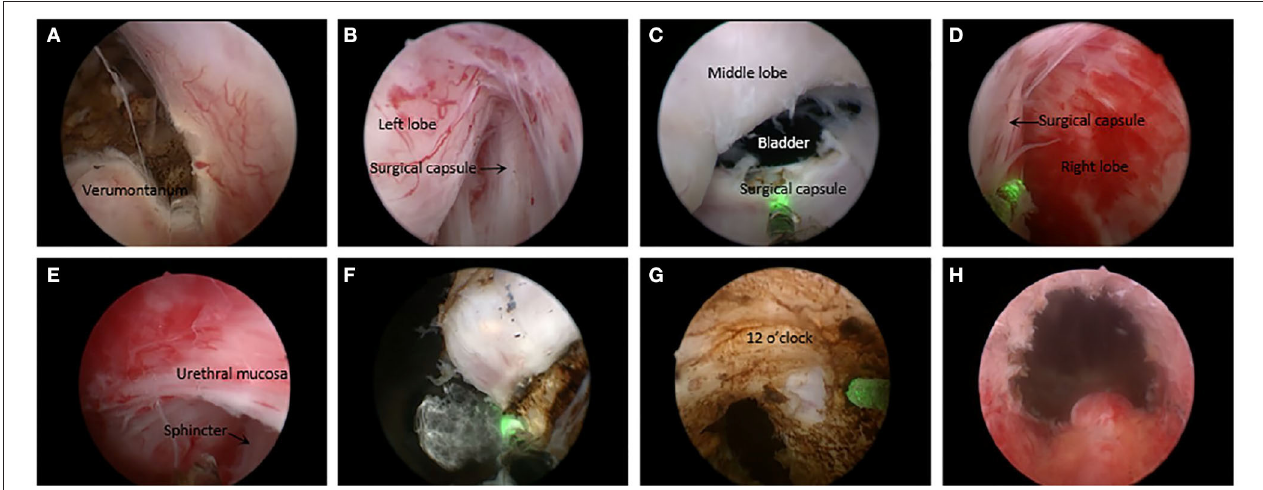
FIGURE 1 | Overview of the non-morcellator technique. (A) Making an inverted-U shaped incision line. (B) Dissecting the left lobe from the obtained surgical capsule up to 1 o’clock with resectoscope. (C) Freeing the middle lobe from the surgical capsule toward the bladder neck. (D) Enucleating the right lobe similarly to 11 o’clock. (E) Truncating the urethral muscosa along the surface of the enucleated lobe at the apex of prostate. (F) Incising and vaporizing the lobes attached to the remaining tissue from 11 to 1 o’clock into small pieces. (G) Resecting the remaining tissue from 11 to 1 o’clock. (H) Postoperative effect.